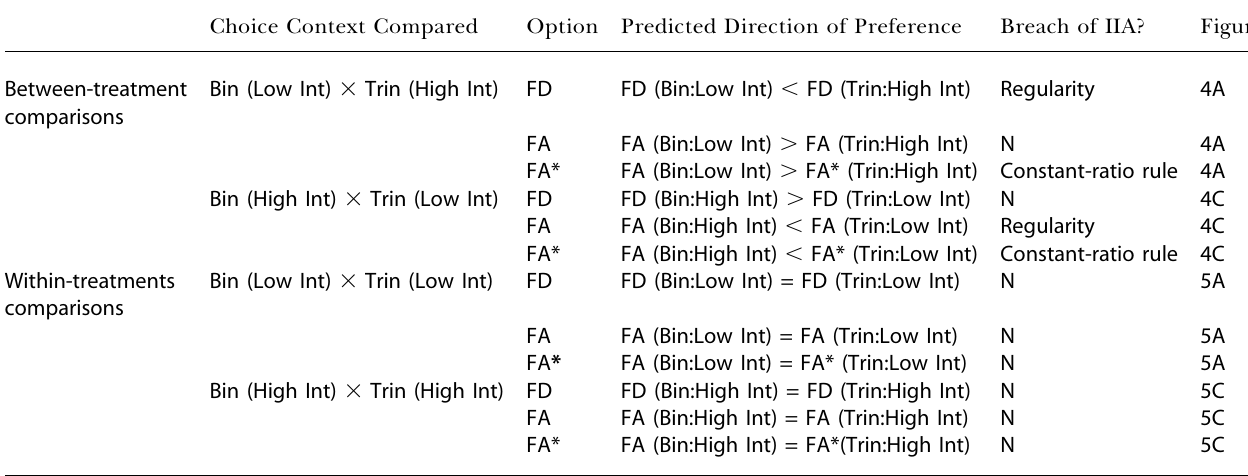
Table 1. Between- and Within-Treatments Comparison of Binary and Trinary Choice Trials for Group NC Choice Context Compared Option Predicted Direction of Preference